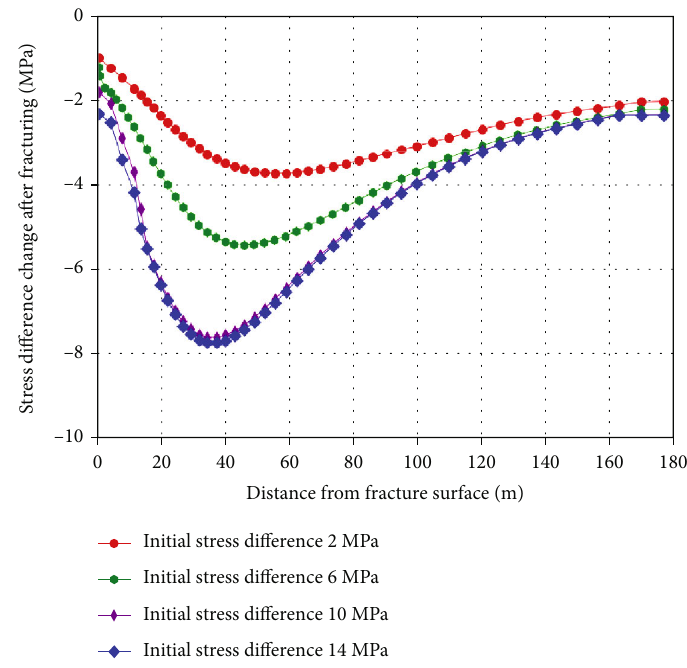
Figure 6: Variation results of in situ stress di ff erence at di ff erent distances from the fracture surface.